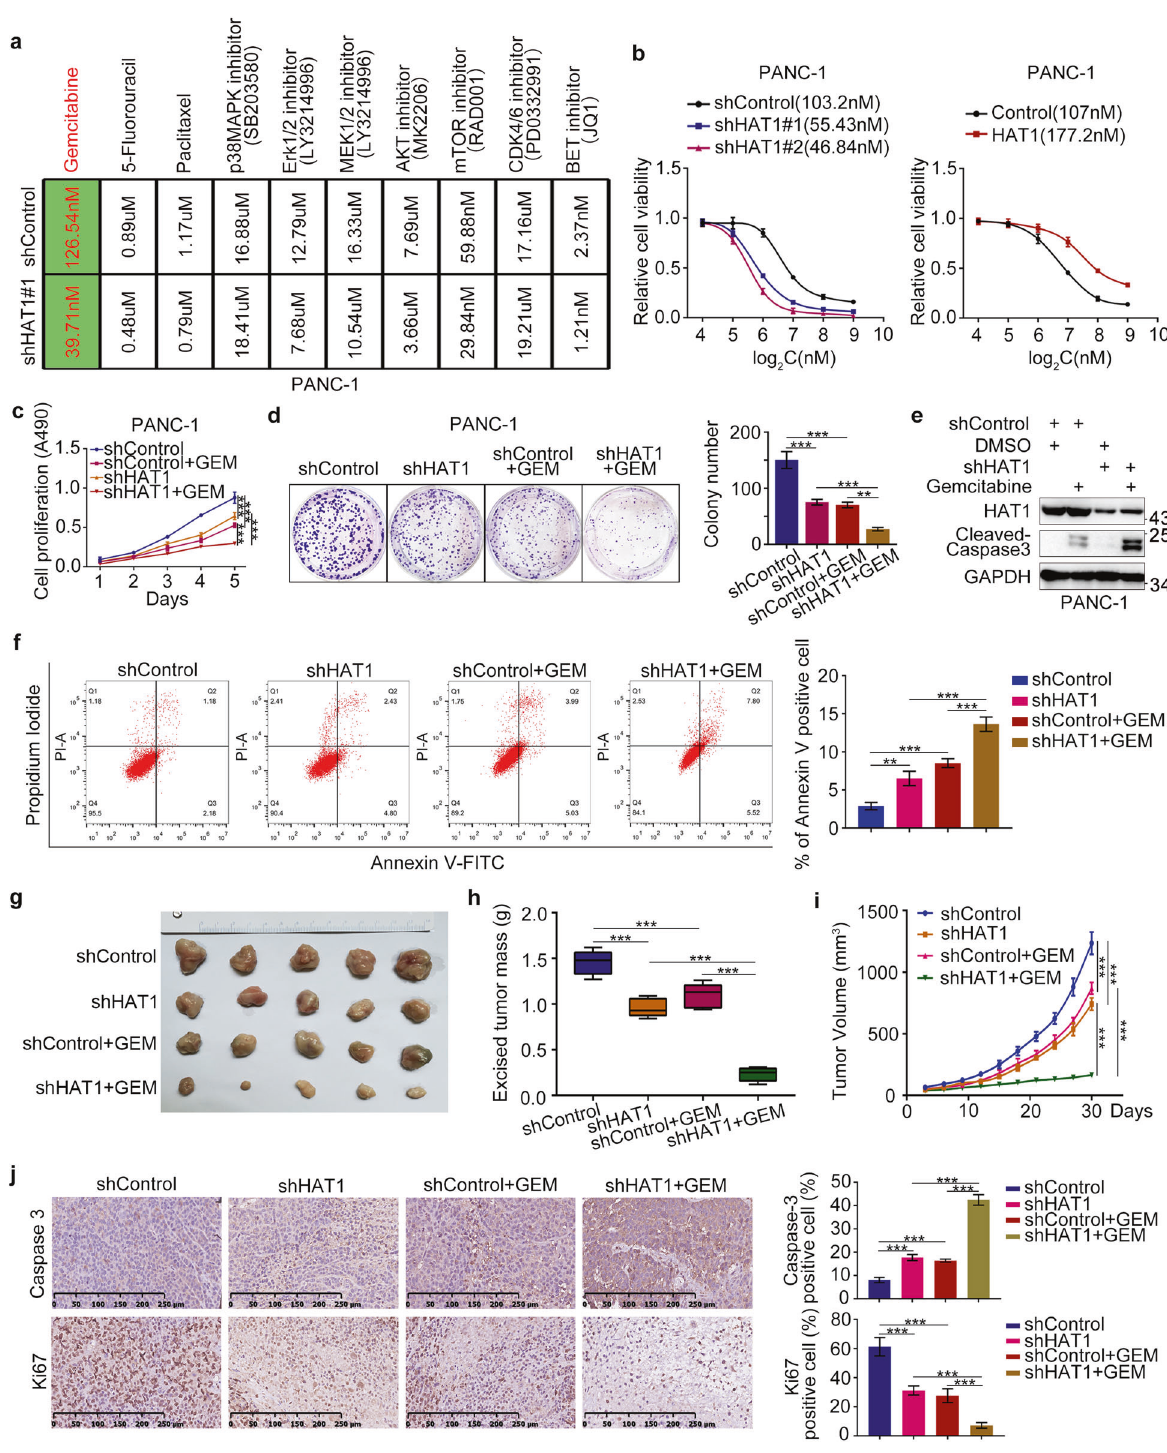
Fig. 1 Aberrant HAT1 expression promotes gemcitabine resistance in pancreatic cancer cells. a MTS assay was used to detect the viability of PANC-1 after treating with different drugs. GraphPad Prism 7.0 software was used to calculate IC50. b MTS assay detected the viability of PANC-1 cells with normal, knockdown, and overexpressing HAT1 after treatment with gemcitabine. The cell viability curve showed IC50 values of gemcitabine among different groups. c – f PANC-1 cells were infected with lentivirus expressing control or HAT1-speci fi c shRNAs. After infecting 72 h, cells were harvested and treated with gemcitabine (50 nM) for MTS assay ( c ), colony formation assay ( d ), cleaved caspase-3 activity assay ( e ), and Annexin-V/Propidium Iodide assay ( f ). All data were shown as mean values ± SD ( n = 3). ** P < 0.01; *** P < 0.001. g – j PANC-1 cells were transfected with indicated plasmids for 72 h. Cell were subcutanousely injected into the nude mice. These mice were injected intraperitoneally with or without gemcitabine (10 mg/kg) every 3 days when tumor volume reached to 50 mm 3 . The tumor volume was measured every 3 days and all tumors were harvested for photograph and weight after 30 days ( g – i ). All tumors were conducted caspase- 3 and Ki67 analysis by IHC staining ( j ). Data presented as Means ± SD ( n = 5). *** P < 0.001.